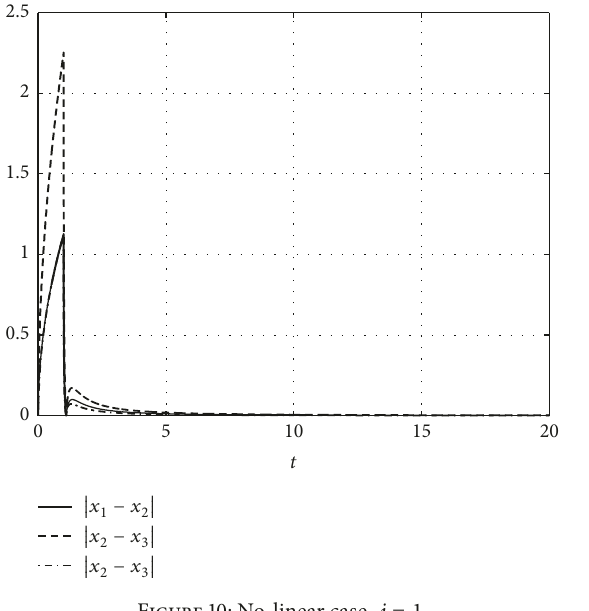
Figure 12: No-linear case, 𝑗 = 4 .